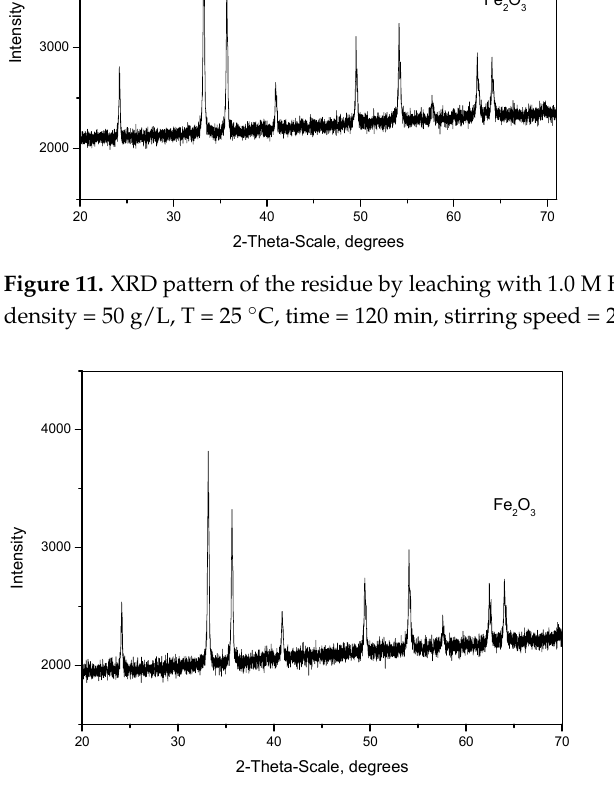
Figure 12. XRD pattern of the residue by leaching with 0.05 M H 2 SO 4 in EG. Operation conditions: pulp density = 50 g/L, T = 25 °C, time = 60 min, stirring speed = 400rpm.